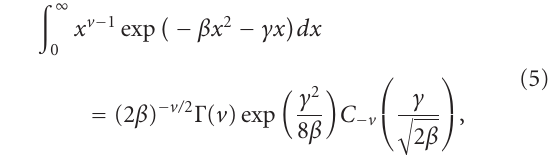
1 N.B. There is a minor typographical error (a missing factor of − 1) in the version of this equation printed in [16], which is corrected within